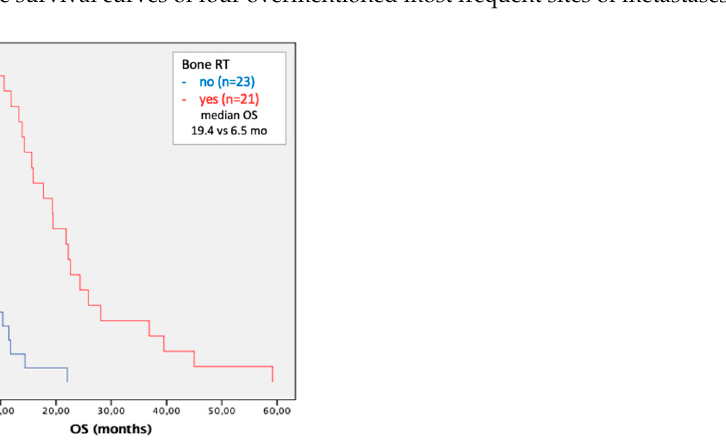
Figure 5. Kaplan–Meier curves of radiological progression-free survival for each site of metastases. The last figure compares the survival curves of lymph node, lung, bone and adrenal gland site of metastases.